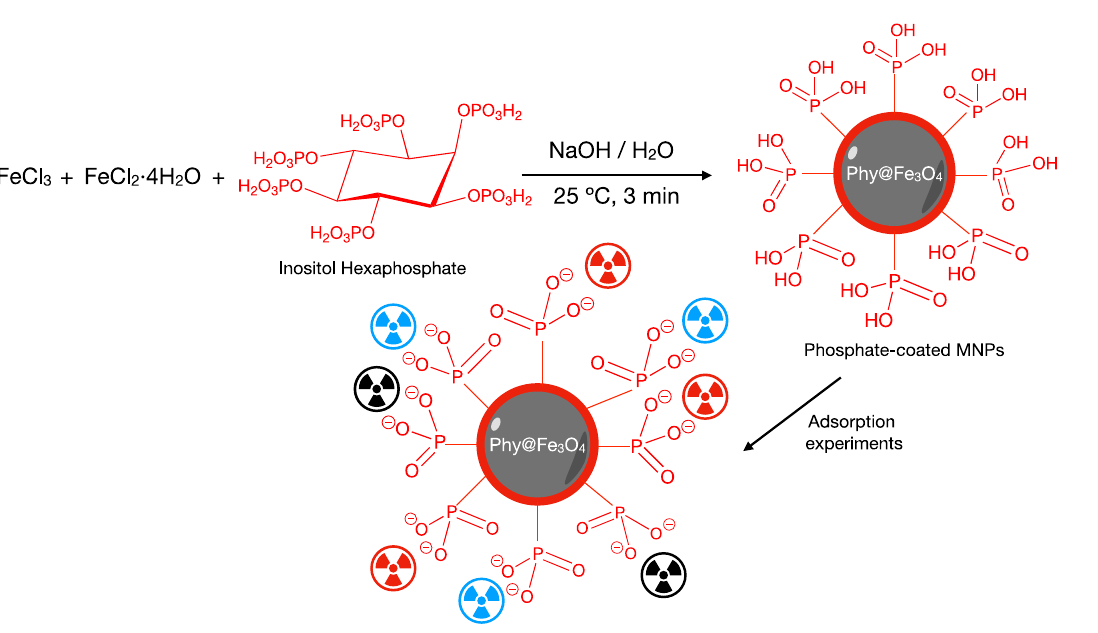
Figure 1. Scheme of the procedure of synthesis and functionalization of the magnetite nanoparticles with phytate. Schematic illustration on the adsorption mechanism.